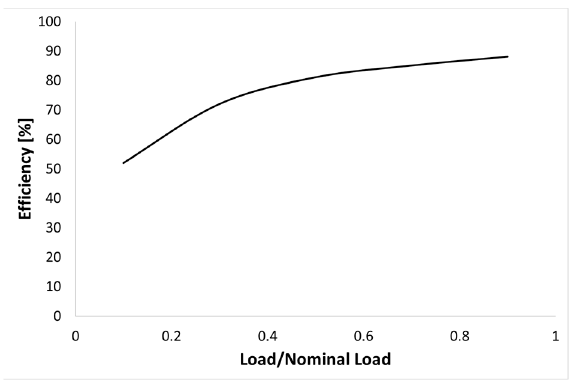
Figure 6. The auxiliary boiler efficiency curve as a function of the ratio between the actual load and the nominal load.